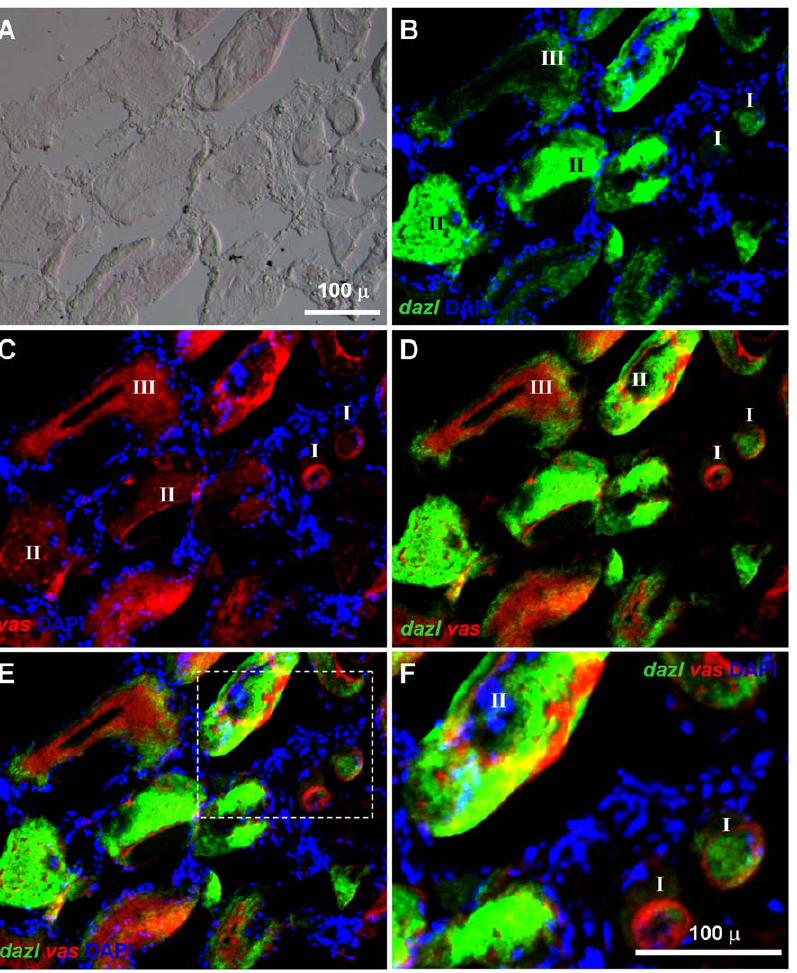
Figure 7. Expression of trout dazl and vasa RNA in trout oogenesis. After hybridization with antisense trout dazl and vasa RNA probes, the signals were visualized by fluorescence staining. Nuclei were stained blue by DAPI. (A–D) Bright-field, green fluorescent, red fluorescent optics and merge, respectively, showing independent subcellular distribution of dazl and vasa RNAs. Scale bars, 100 m m.